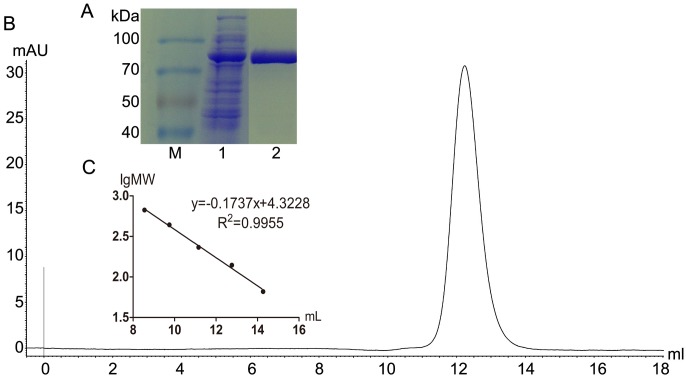
Determination of the molecular weight and oligomeric state of Aga-BC7050 by analytical gel filtration.(A) SDS-PAGE analysis of Aga-BC7050. Lanes: M, protein molecular markers; 1, crude lysate; 2, purified Aga-BC7050. (B) Elution profile from the analysis of purified Aga-BC7050. (C) Calibration curve using protein standards: albumin, 66.0 kDa; lactate dehydrogenase, 140.0 kDa; catalase, 232.0 kDa; ferritin, 440.0 kDa; thyroglobulin, 669.0 kDa.